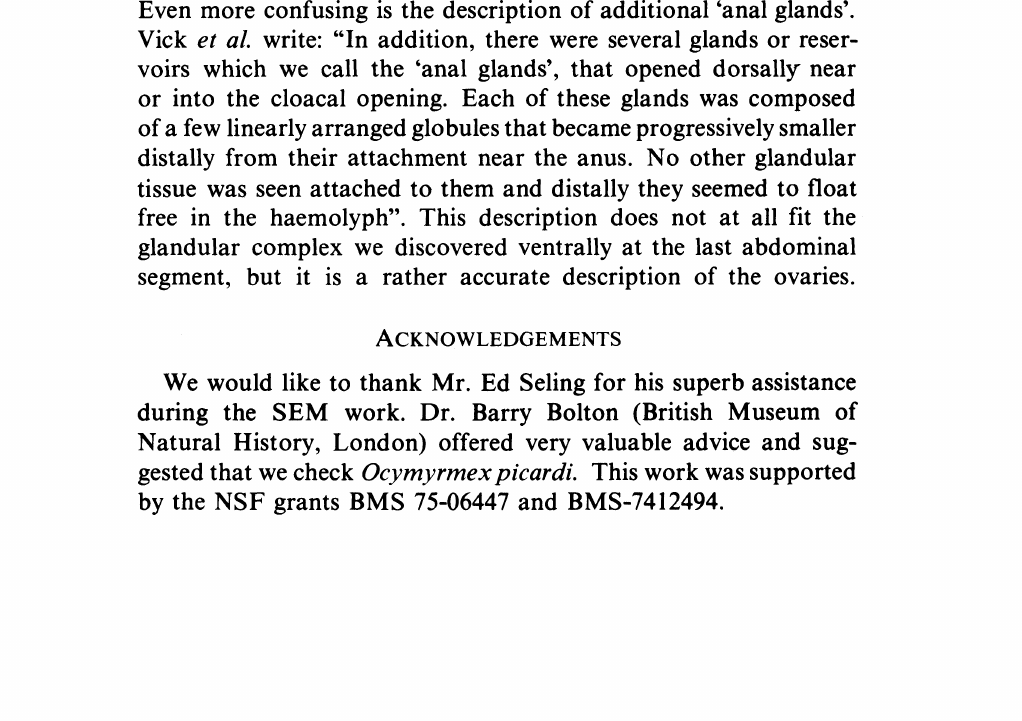
Figure 5. SEM picture of a dried specimen of a Ocymyrmex picardi worker showing the net-like cup